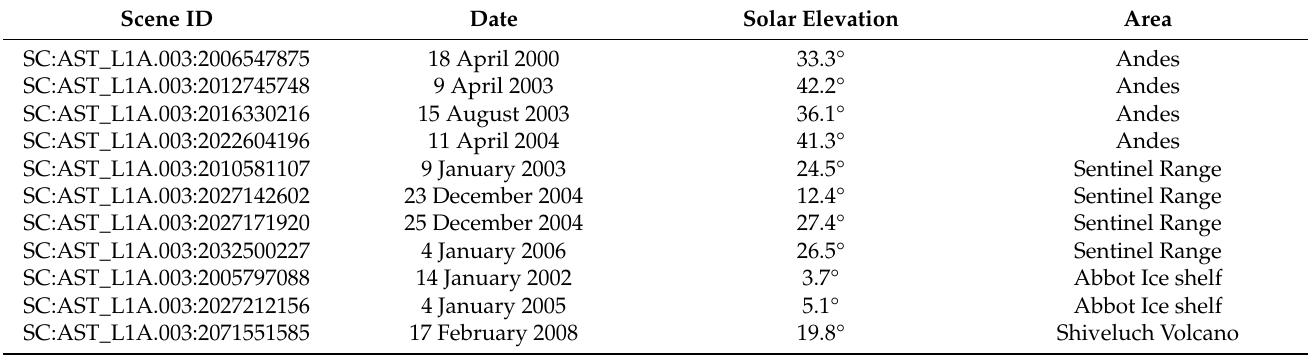
Table 2. ASTER L1A v.3 scenes used for